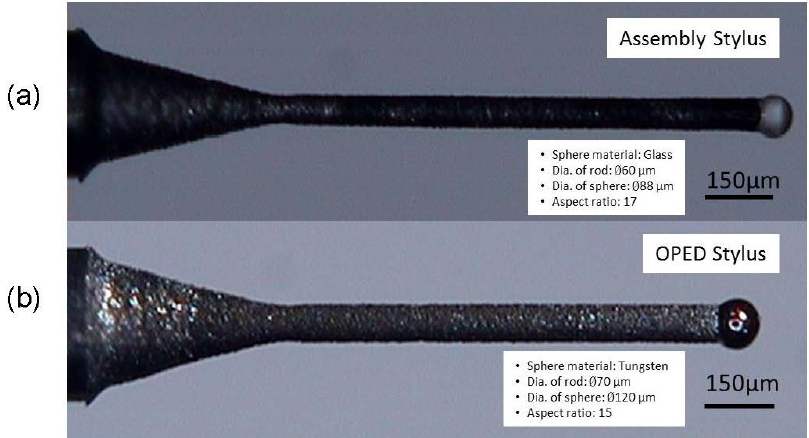
Figure 3. Stylus tips produced by an ( a ) assembly process called WEDG (Wire Electrical Discharge Grinding) process and the ( b ) OPED (One Pulse Electrical Discharge) process.